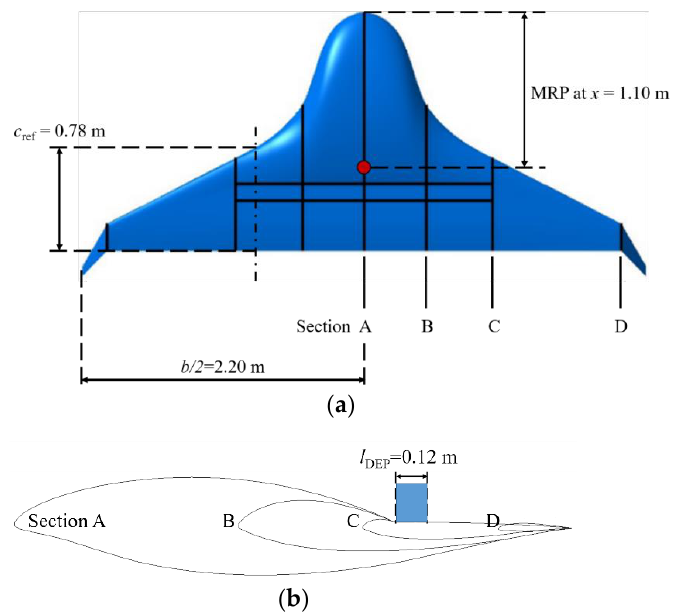
Figure 2 . Baseline BWB configuration under DEP installation constraints. ( a ) BWB planform sketch. ( b ) Sectional airfoil profiles. Table 2 . Characteristic sectional airfoil parameters.